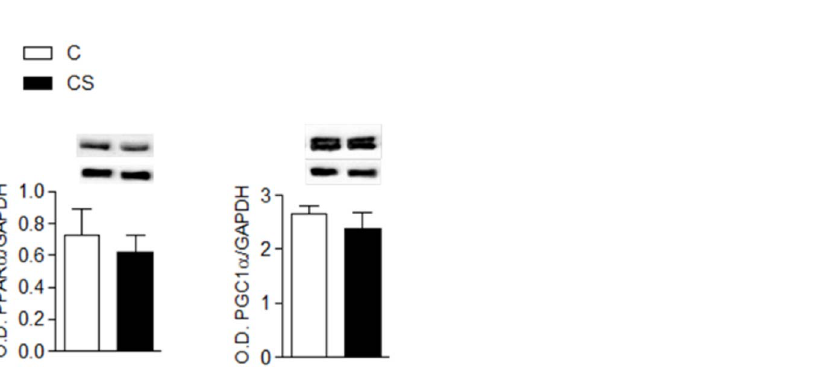
Figure 2. Modulators of FA oxidation and mitochondrial biogenesis. C: control group; CS: cigarette smoke group; O.D.: optical density; GAPDH: glyceraldehyde-3-phosphate dehydrogenase; MW: molecular weight. 2A : upper bands: PPAR a : peroxisome proliferator-activated receptor alpha; lower-bands: GAPDH; PPAR a /GAPDH: C vs. CS p 5 0.6. 2B : upper bands: PGC-1 a : peroxisome proliferator-activated receptor gamma coactivator 1 alpha; lower bands: GAPDH; PGC-1 a /GAPDH: C vs. CS p 5